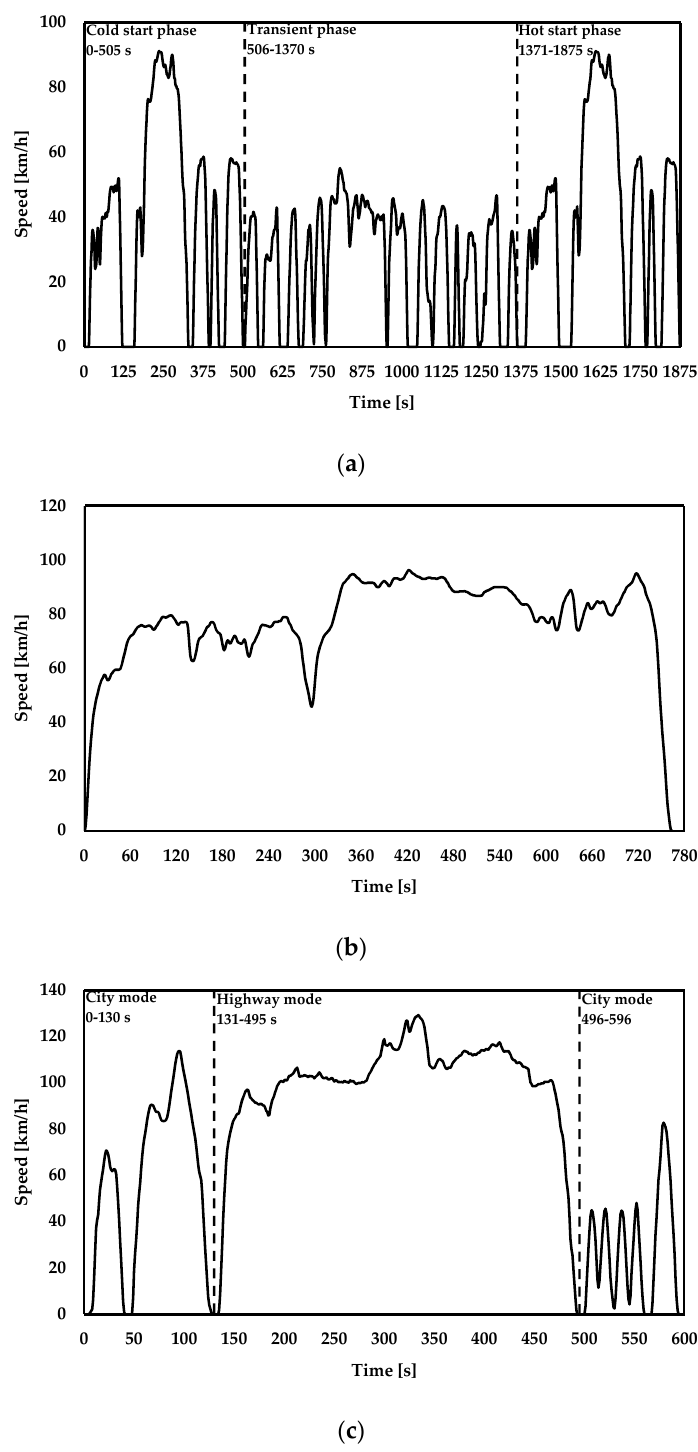
Figure 3. Three regulatory driving cycles established by the Environment Protection Association (EPA). ( a ) FTP-75 driving cycle, ( b ) highway mode (HWFET) driving cycle, and ( c ) US06 driving cycle.